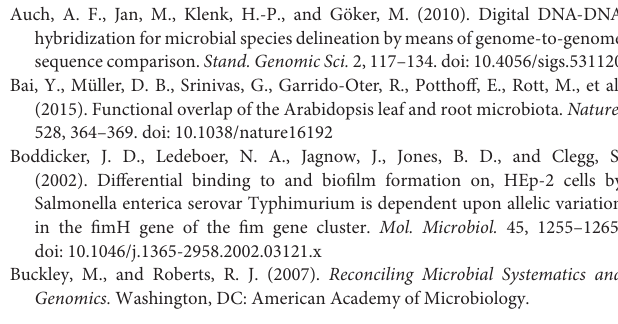
poison ivy vine tissue. Supplemental Figure 2 | Genomic clustering of Clade 1 using ANIm calculation. Supplemental Figure 3 | Genomic clustering of Clade 2 using ANIm calculation. Supplemental Figure 4 | Genomic clustering of Clade 3 using ANIm calculation. Supplemental Figure 5 | Genomic clustering of other Pseudomonas strains using ANIm calculation. Supplemental Table 1 | Genomic clusters of Clade 1, Clade 2, Clade 3 and other Pseudomonas strains with suggested assignation. Mislabeled genomes are indicated with asterisk whereas type strains are labeled